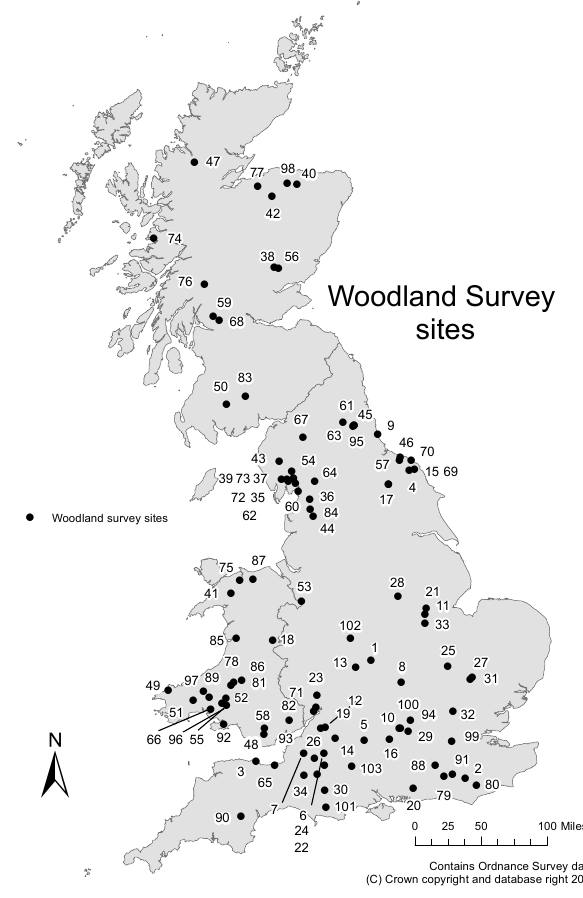
Figure 1. Map of woodland survey site locations across Great